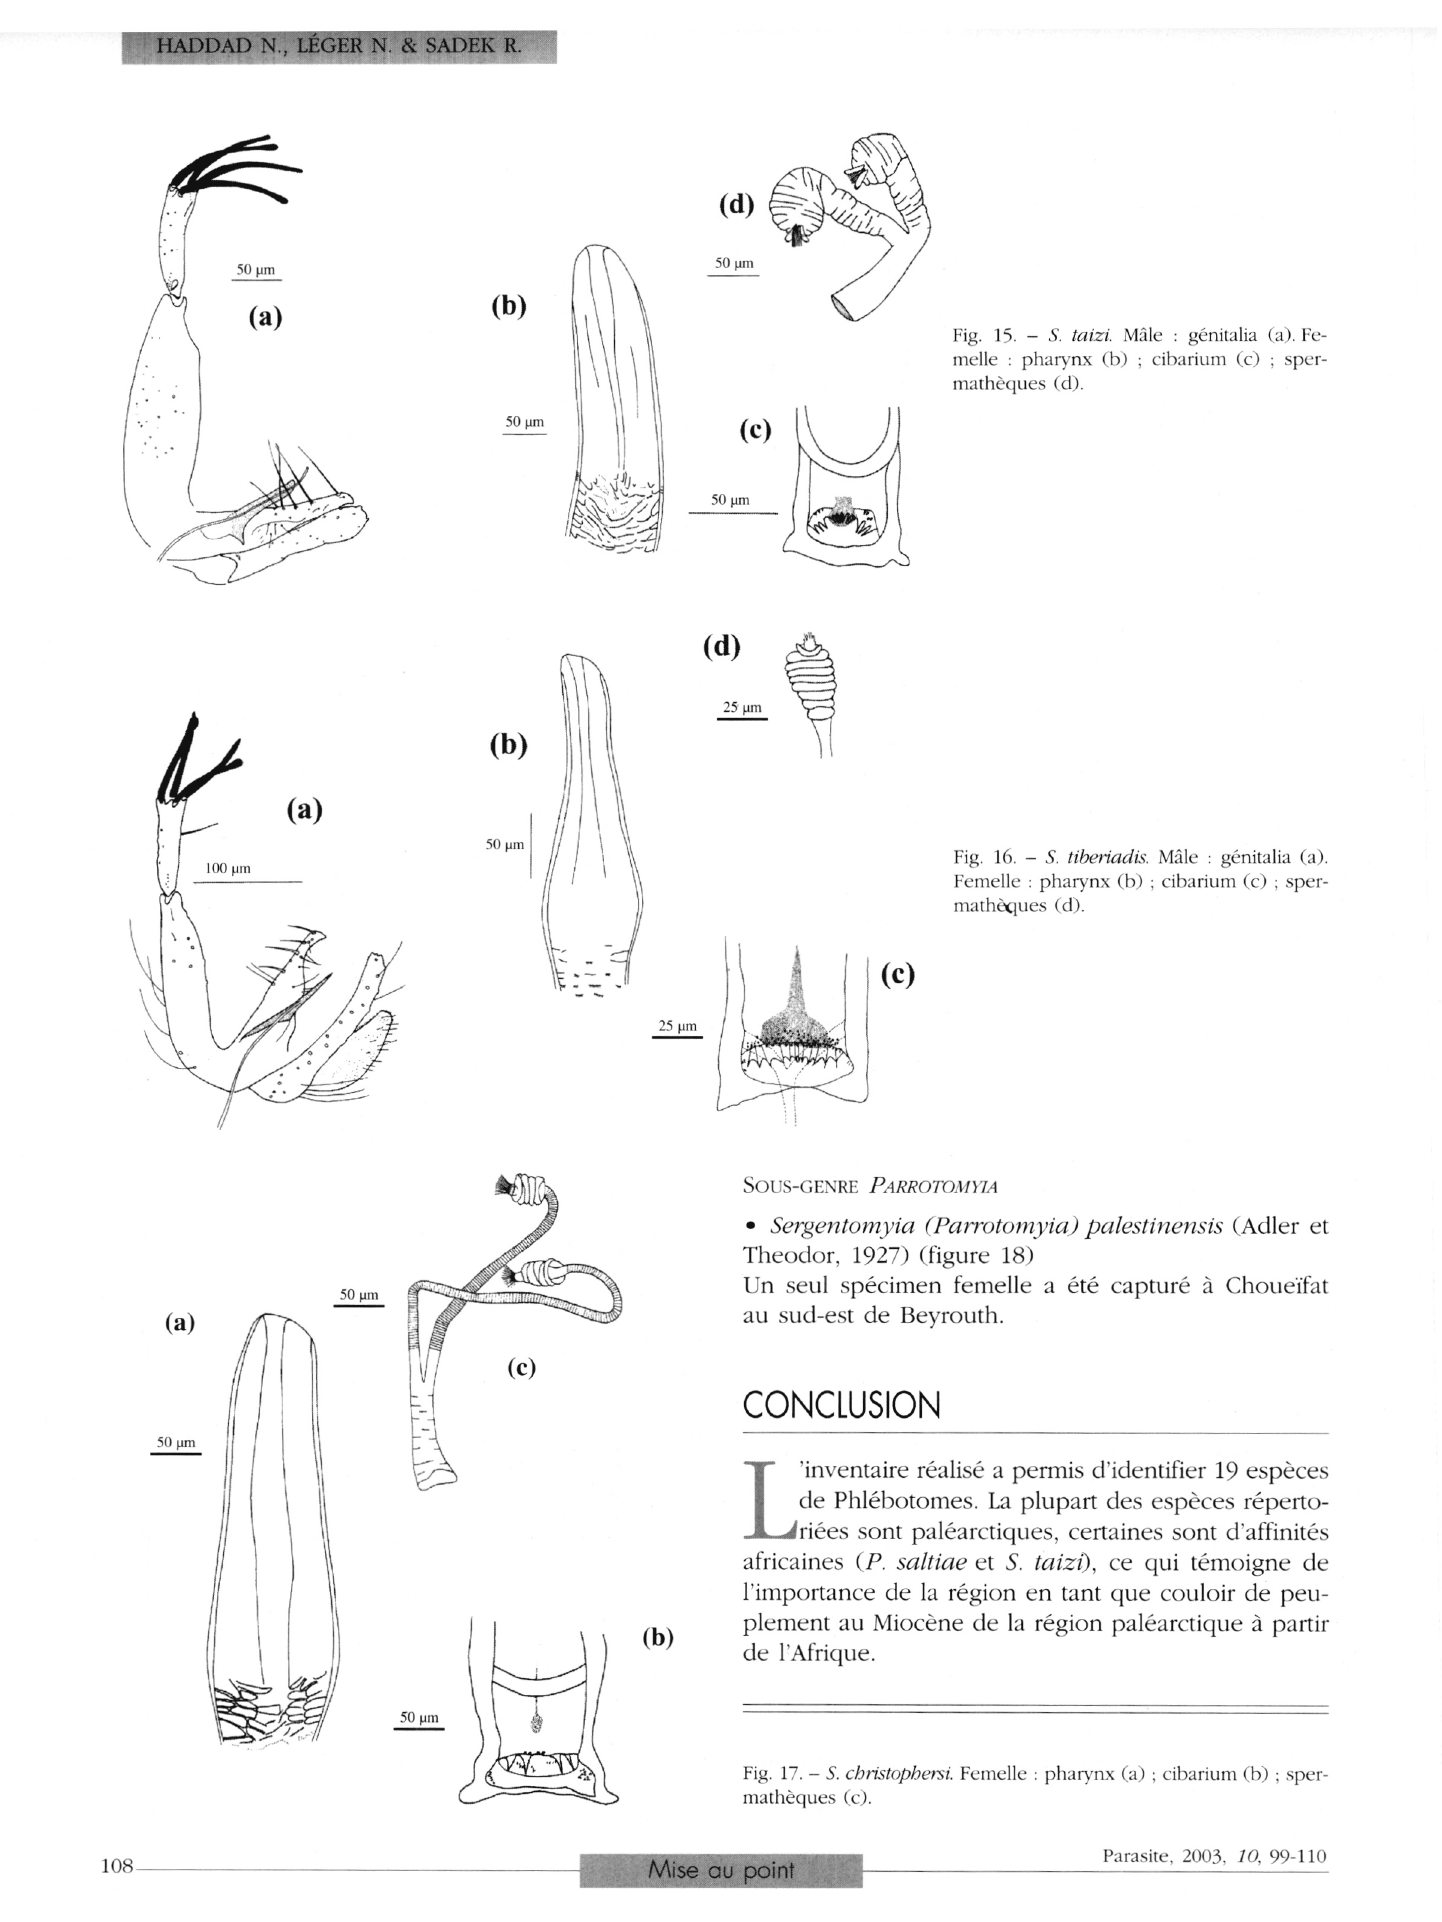
Fig. 17. - S. christophersi. Femelle : pharynx (a) ; cibarium (b) ; sper- mathèques